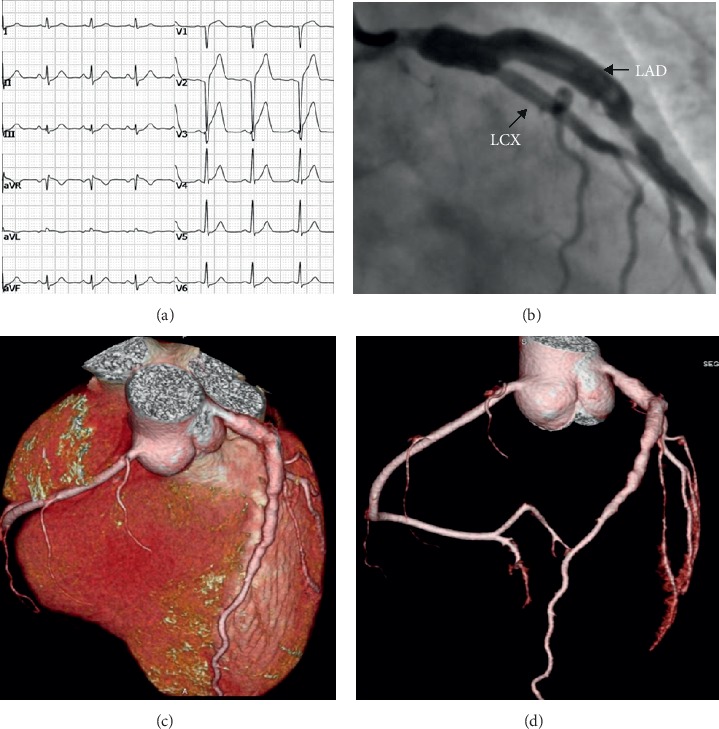
(a) ECG on admission: normal sinus rhythm with ST segment elevation on leads V1–3. (b) CAG: an aneurysmal dilatation from the LMCA to the proximal segment of LAD with a transverse diameter of 8.5 mm. (c, d) Coronary CTA with three-dimensional volume rendering: multiple aneurysms from the LMCA to the proximal segment of the LAD artery.